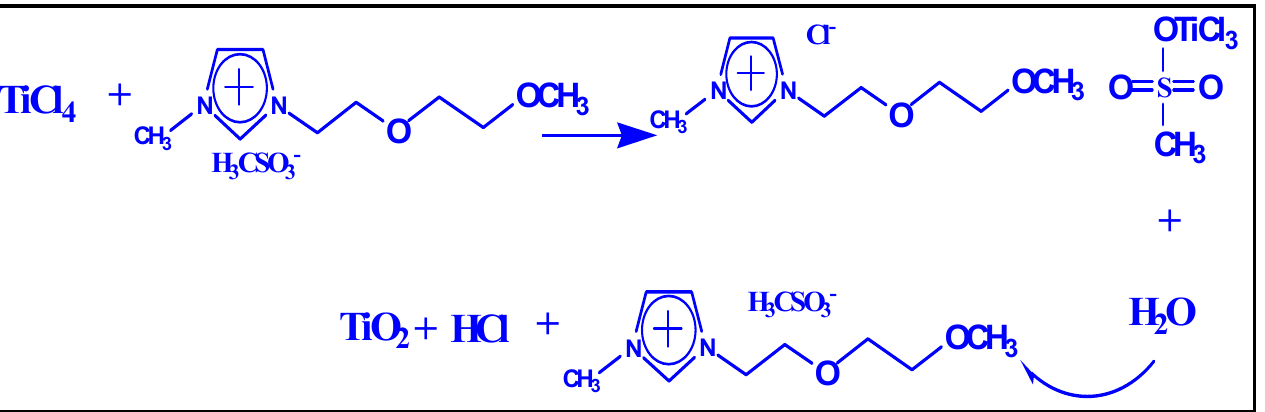
Figure 2. Mechanism describing the reaction of TiCl 4 andionic liquid.